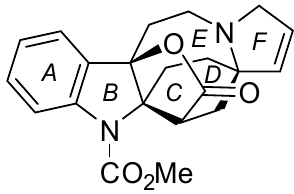
Figure 1. Lapidilectine B ( 1 ).